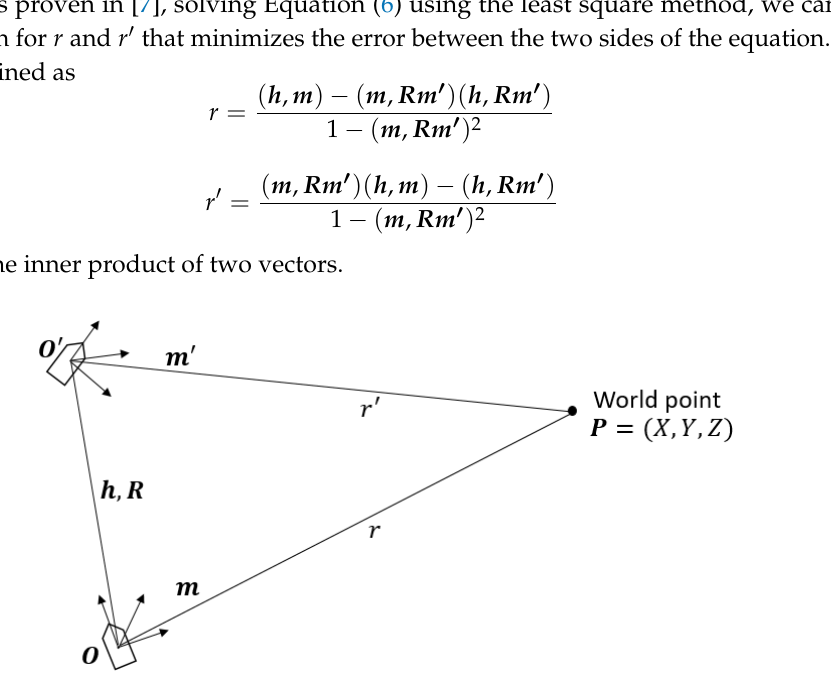
Figure 2. Illustration of motion